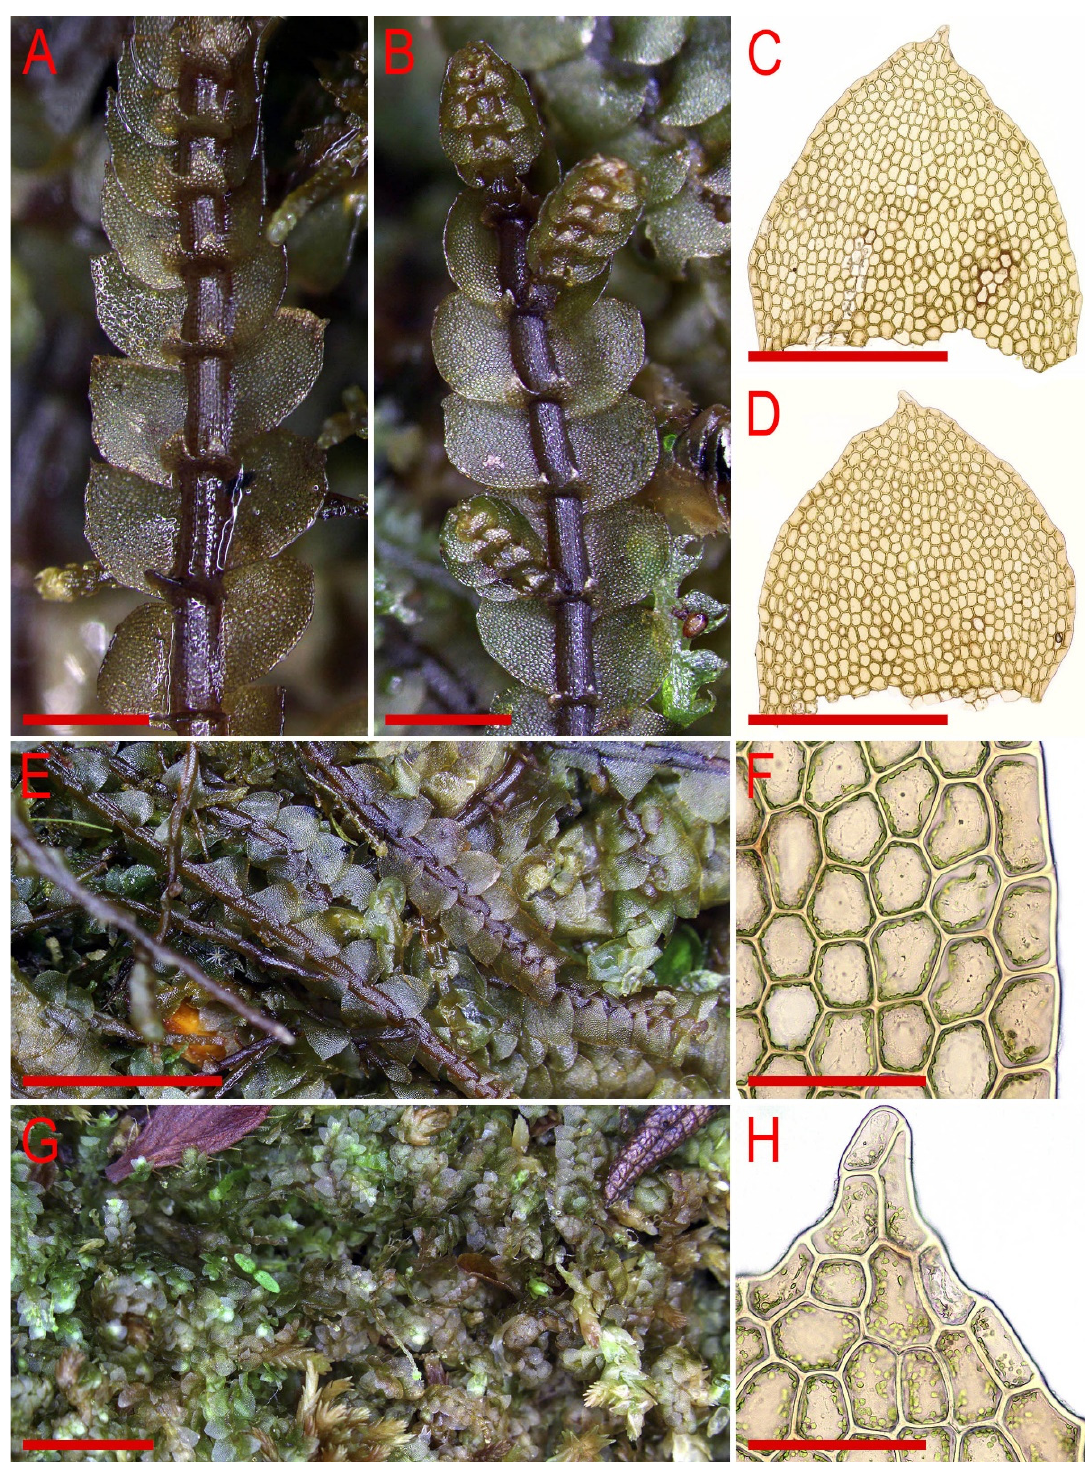
Figure 16. Calypogeia pseudocuspidata Bakalin, Frank Müll. et Troizk., sp. nov. : ( A , B ) Plant habit, fragment, ventral view; ( C , D ) Leaves; ( E ) Part of mat; ( F ) Leaf margin cells; ( H ) Leaf apex cells. Calypogeia pseudosphagnicola Bakalin, Troizk. et Maltseva, sp. nov. : ( G ) Mat. Scales: 1 mm for ( A , B ); 500 μ m for ( C , D ); 100 μ m for ( F , H ); 5 mm for ( E , G ). ( A – F , H ) from V-21-18-18; ( G ) from Kh-40-36-13. All from VBGI.